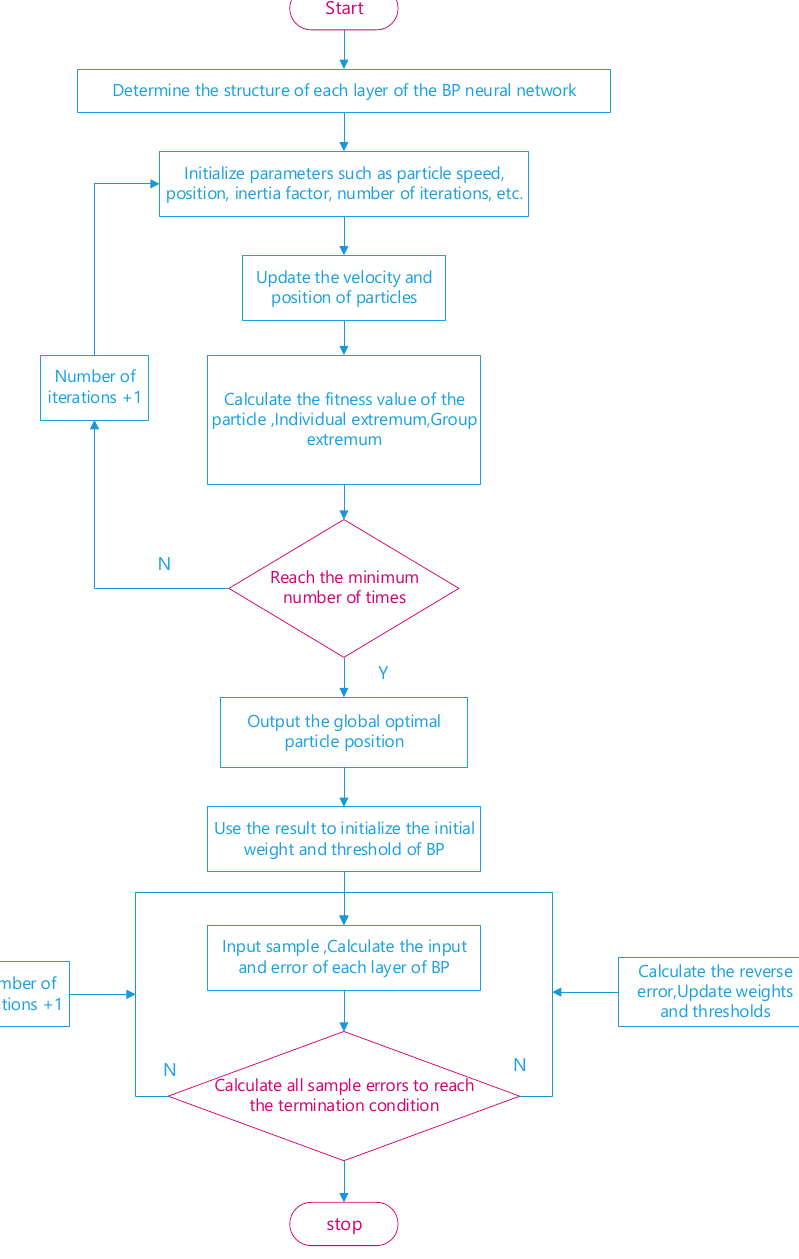
Figure 10. Algorithm flow of PSO-BP.